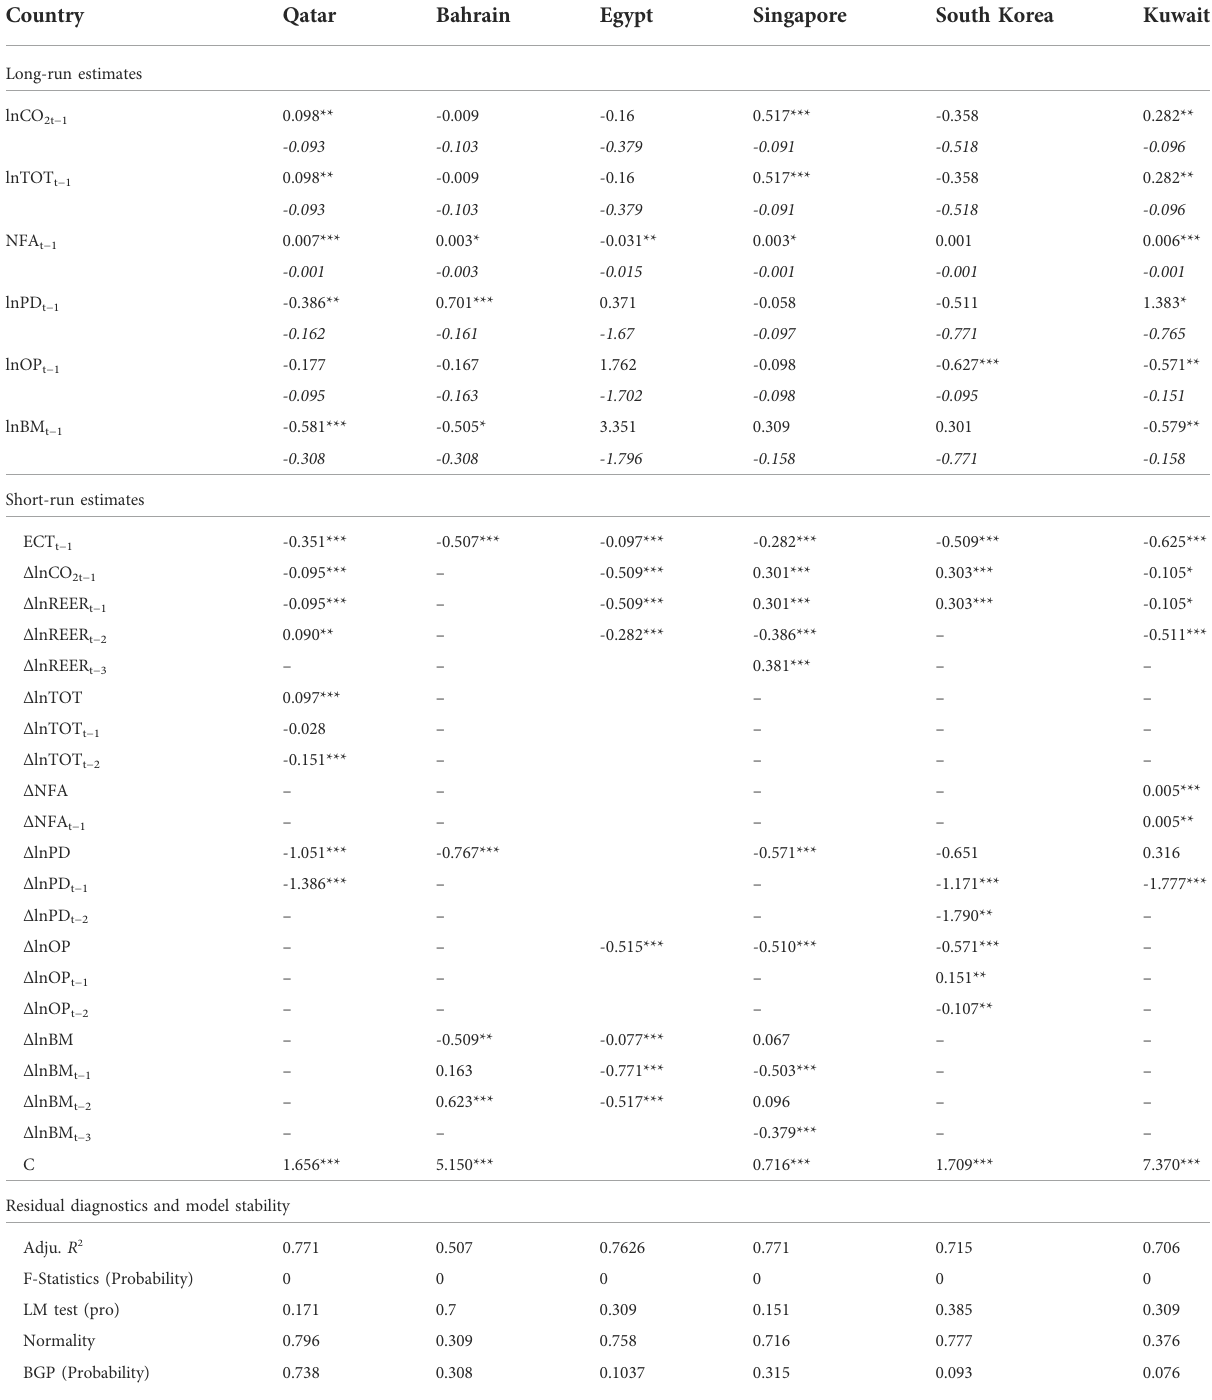
TABLE 6 Coef fi cients of ARDL estimation for the RER model.